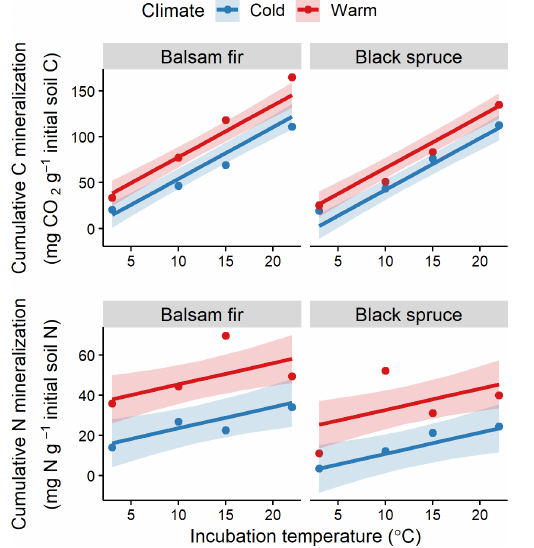
Figure 4. Fitted relationships for organic layer cumulative soil CO 2 –C and N mineralisation with incubation temperature, site cli- mate (warm vs. cold) and tree species (balsam fir vs. black spruce). Red colour identifies warm sites and blue colour cold sites, with points showing observed values. Shaded areas indicate 95% confi- dence